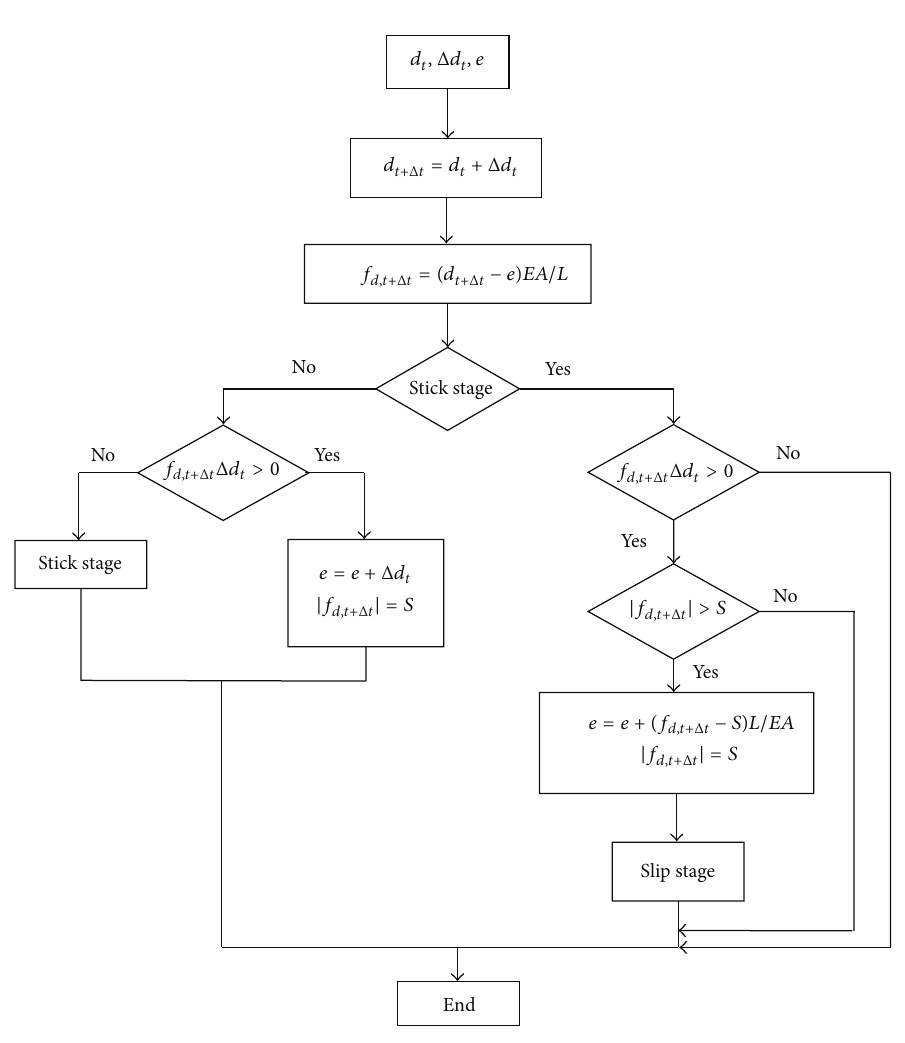
Figure 5: Force flow chart of passive